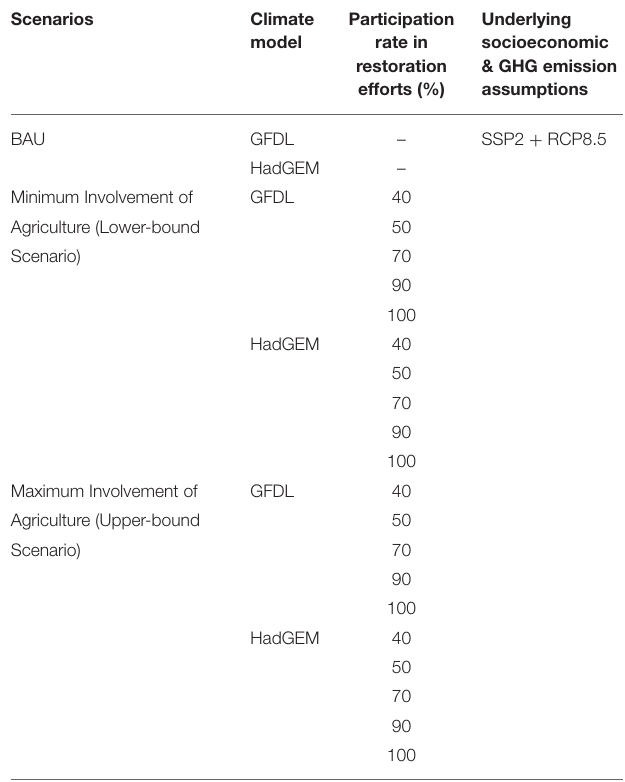
TABLE 2 | Summary of all scenarios